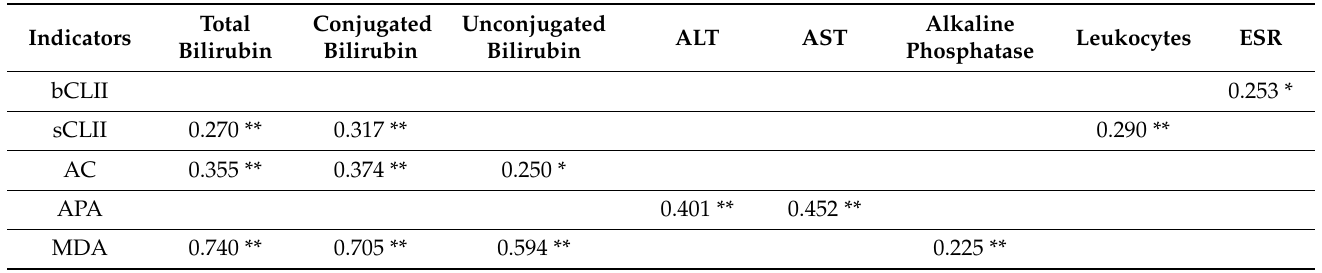
Table 6. Correlation analysis of free radical processes’ indicators with indicators of bilirubin, AST, ALT, the number of leukocytes and ESR examined in the blood of patients with jaundice on the first day of hospitalization (the correlation matrix contains only reliable relationships with a strength higher than 0.2).